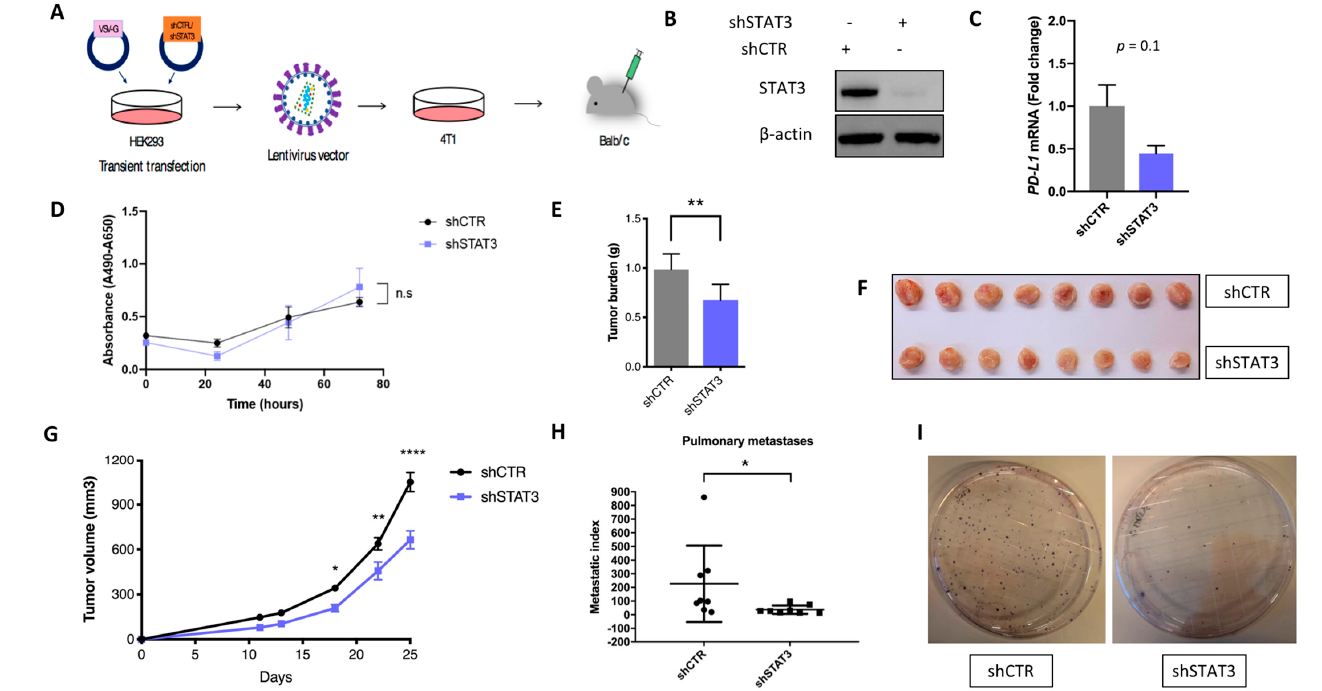
Figure 3. STAT3-mediated regulation of PD-L1 and effect on tumor growth and metastatic dissemination in vivo. ( A ) Schematic representation of the generation of the 4T1 breast cancer mouse model from transient transfection of HEK293 cells with shCTRL/sh Sta3 plasmids and production of lentiviruses to transduction of 4T1 mouse breast cancer cell line, which was injected into the mammary fat pad of to Balb/c mice. ( B ) Downregulation of STAT3 protein levels in 4T1 cell line as assessed via immunoblotting upon sh STAT3 plasmid transduction. ( C ) Decreased pd-l1 transcript levels in sh Stat3 4T1 cell line as evaluated by qPCR. qPCR data are depicted as the fold change relative to control and are normalized to 18S rRNA. Data represent one out of three independent experiments and presented as the mean ± SEM. ( D ) 4T1-shCTRL and 4T1-sh STAT3 were cultured for three days under normal conditions and XTT proliferation assay was performed to assess cancer cell proliferation. The proliferation rate of Stat3 silenced cells was not significantly changed compared to the control cells. Each time point denotes the mean of six replicates (±—standard deviation, SD). Two-way ANOVA test was used. ( E – G ) 4T1-shCTRL and 4T1-sh Stat3 tumor cells were injected into the mammary fat pad of BALB/c mice ( n = eight mice per group). Graphs display the tumor weight ( E ) and tumor volume ( G ). Student’s t-test and two-way ANOVA with Sidak’s multiple comparison test were used, respectively (* p < 0.05; ** p < 0.01, *** p < 0.001; **** p < 0.0001). shCTR and s hStat3 mice tumors are depicted in picture ( F ). ( H – I ) The graph depicts metastatic index, which is calculated by the number of well-formed colonies per tumor weight ( H ) (Wilcoxon-Mann-Whitney test, p = 0.0148). Representative photos from the colongenic assay are depicted in figure ( I ).